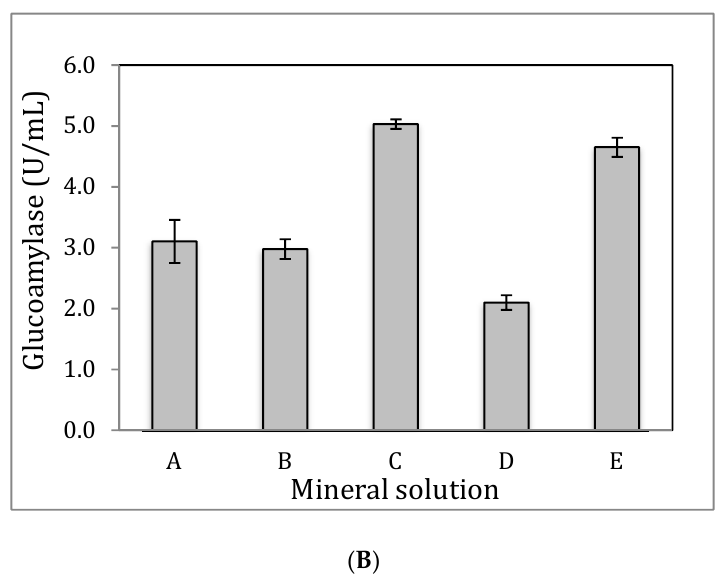
Figure 2. The effect of mineral solution on glucoamylase production in SmF. ( A ): the comparison of gluco-amylase production profile in SmF with and without mineral solution E. ( B ): Gluco-amylase production using mineral solutions A–E, fermentation time 72 h, temperature 28 °C, 4% (w/v) sorghum bran, no extra nutrients, no pH adjustment.